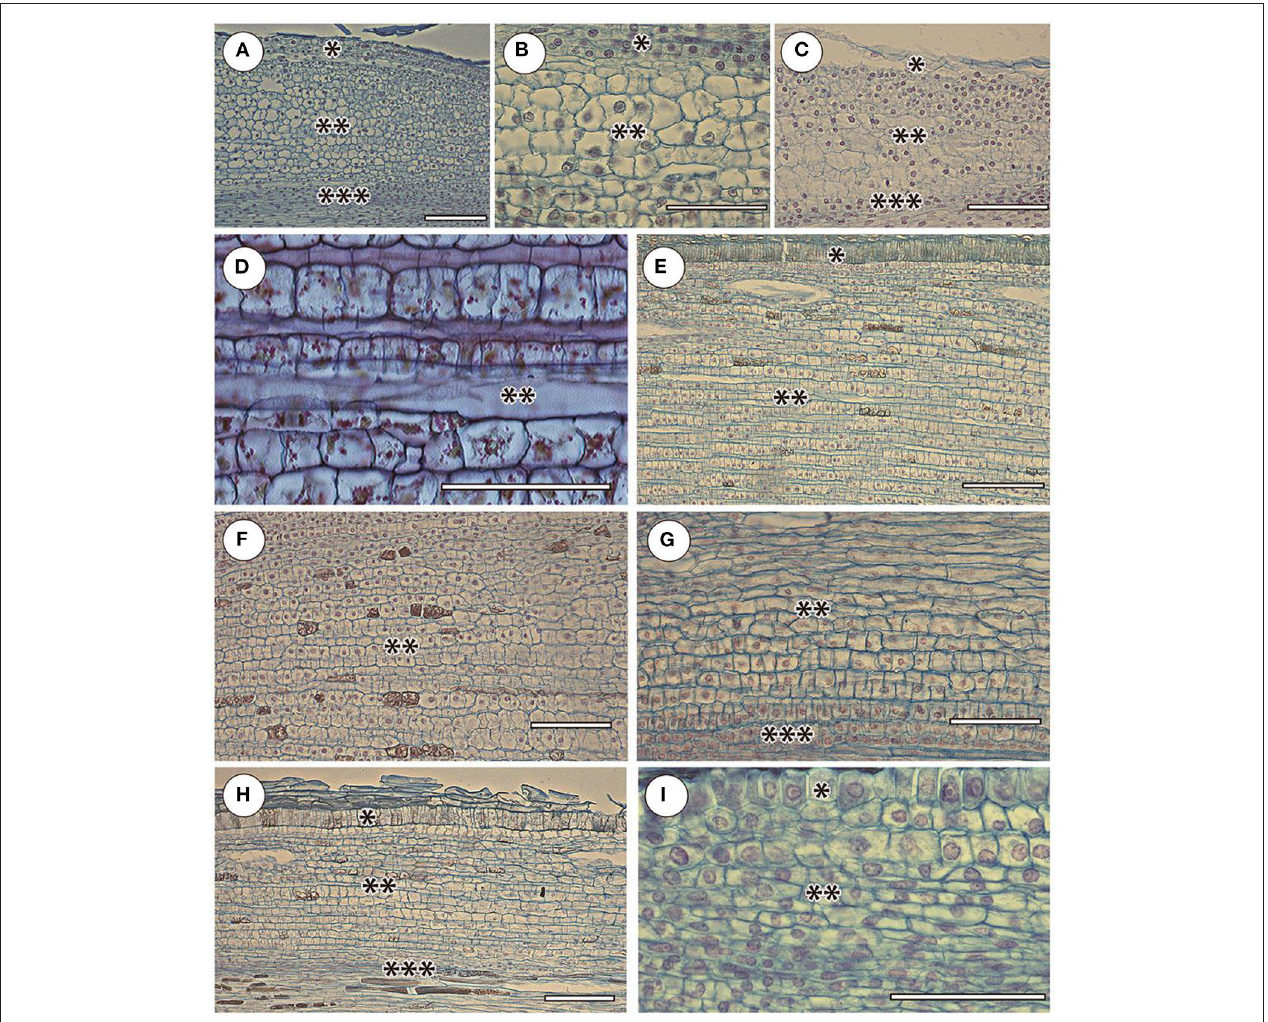
FIGURE 3 | Cortex and adjacent tissues in selected species in the elongation zone. Orchidaceae: (A) Cattleyas skinneri , (B) Neofinetia falcata, (C) Cymbidium finlaysonianum . Araceae: (D) Monstera deliciosa , (E) Philodendron scandens , (F) Anthurium crassinervium . Bromeliaceae: (G) Tillandsia ionantha . Moraceae: (H) Ficus formosana . Cactaceae: (I) Rhipsalis mesembryanthemoides. Sliced tissues: ( * ) protoderm and/or rhizoderm (in orchid velamen); ( ** ) cortex; ( *** ) pericycle. Scale 100 µ